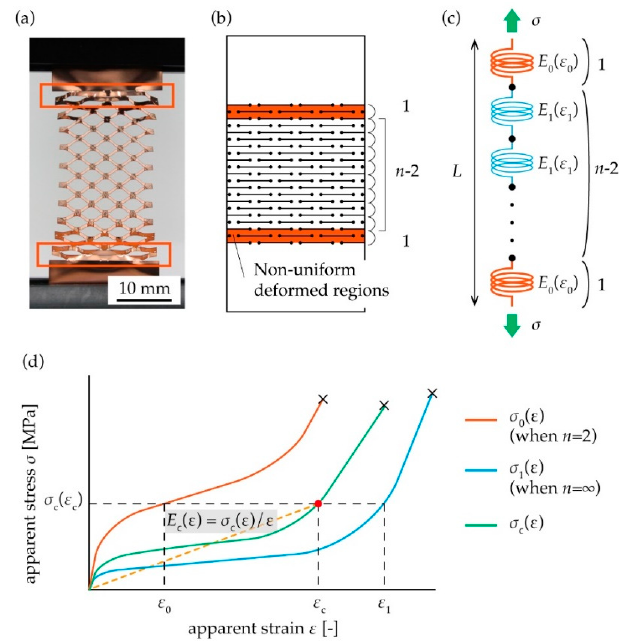
Figure 2. ( a ) Photograph of a stretched kirigami structure. ( b ) Definition of non-uniform deformed regions at both ends. ( c ) A spring model of the kirigami structure, in which two hard springs with an elongation stress per strain E 0 ( ε 0 ) sandwich n − 2 soft springs with an elongation stress per strain E 1 ( ε 1 ). ( d ) The combined stress–strain curve of the whole spring σ c ( ε ) can be obtained from stress–strain curves σ 0 ( ε ) and σ 1 ( ε ) of each spring.